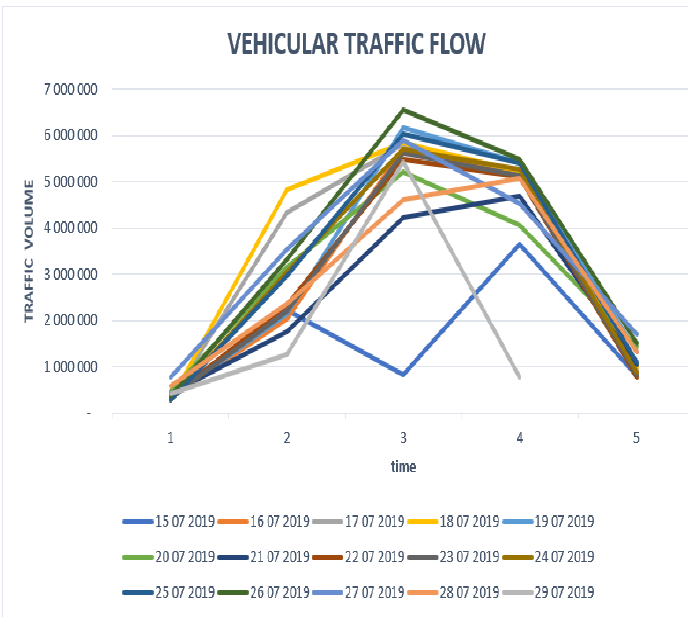
Figure 10. Road intersection 2.